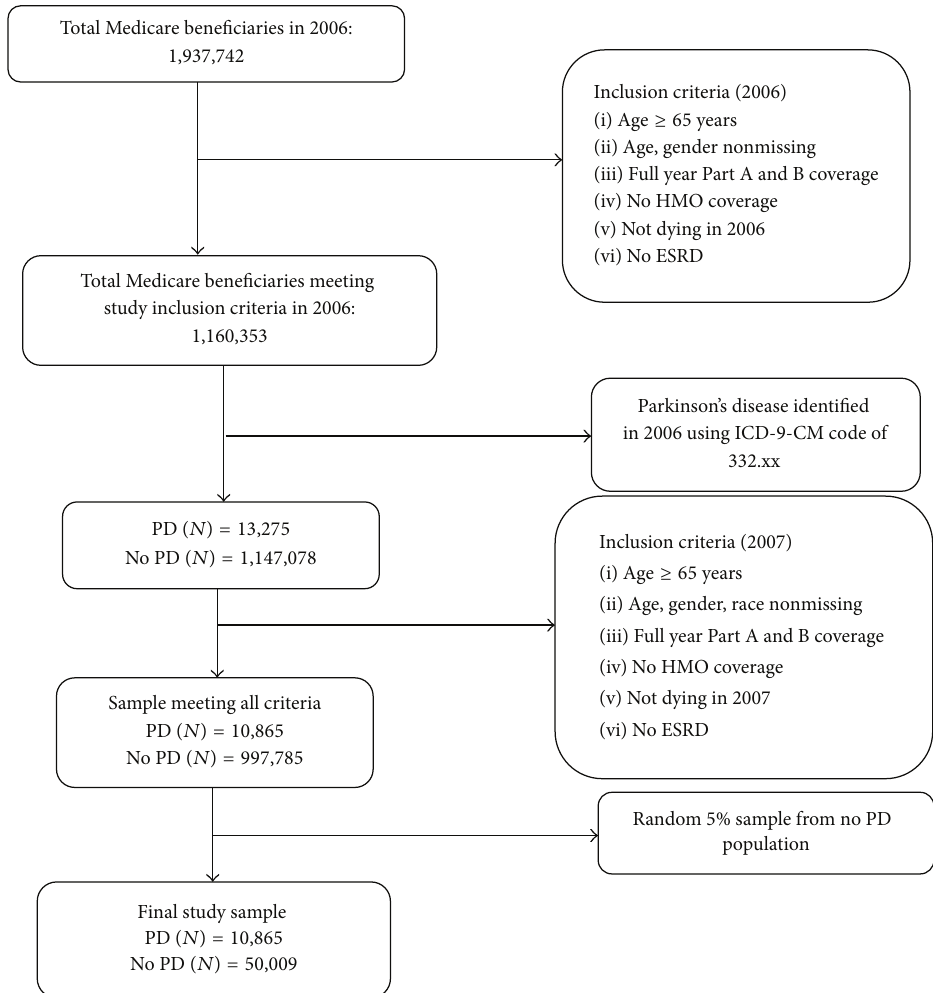
Figure 1: Cohort